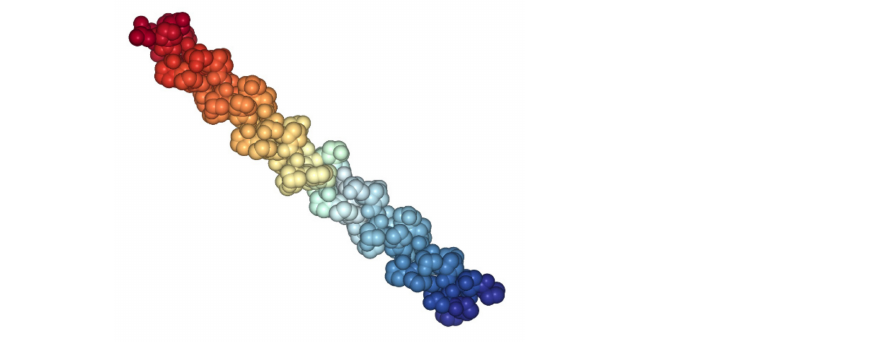
Figure 4. Crystal structure of tropocollagen from Protein Data Bank (PDB), 1cag [40]. Each chain consists of about 1000 amino acids (sometimes more in some types of collagen), three left-handed α -chains make up an extended right-handed helix called tropocollagen. The tight packing of α -chains in tropocollagen requires that every third amino acid is a glycine, resulting in a repeating XaaYaaGly sequence, where Xaa and Yaa can be any amino acid [41]. This structure is common to all collagen types, although it can be disrupted in specific locations within the triple helix of non-fibrillar collagens [42]. The amino acids at the Xaa and Yaa positions are often proline (Pro, 28%) and 4-hydroxyproline (Hyp, 38%), respectively. ProHypGly is the most abundant triplet (10.5%) in collagen [43]. Modern sources often describe 29 types of known collagens [44], (Table 1). Table 1. Types, classes and location of collagen in tissues. Adapted from [45] with additional data from: